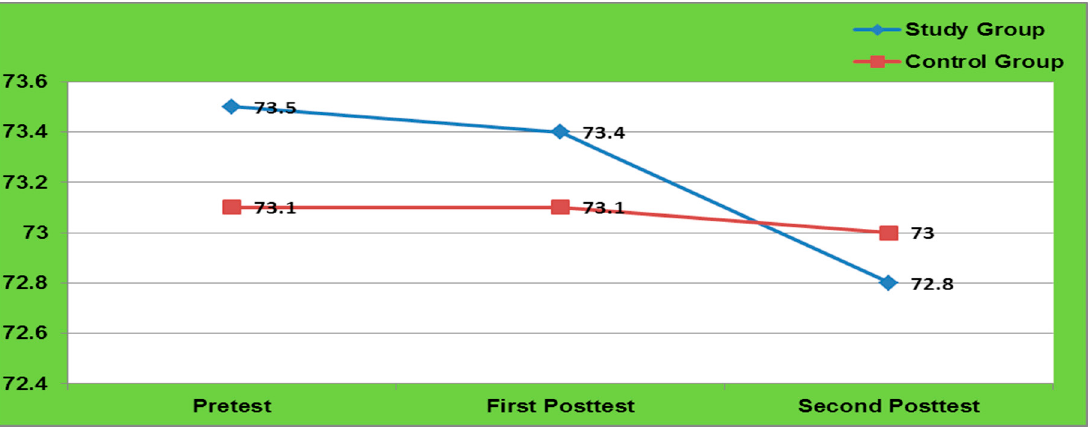
Figure 3. Comparison of DBP among Study and Control Group.